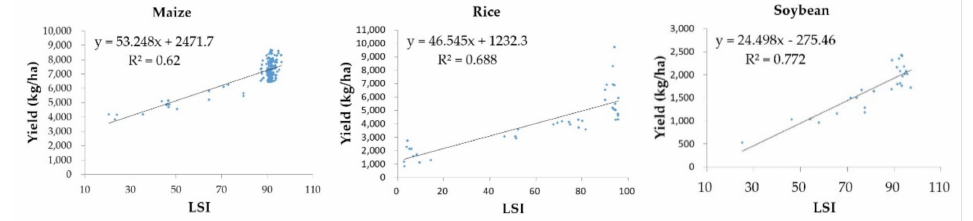
Figure 6. Linear regression between land suitability index and yield data (kg/ha).